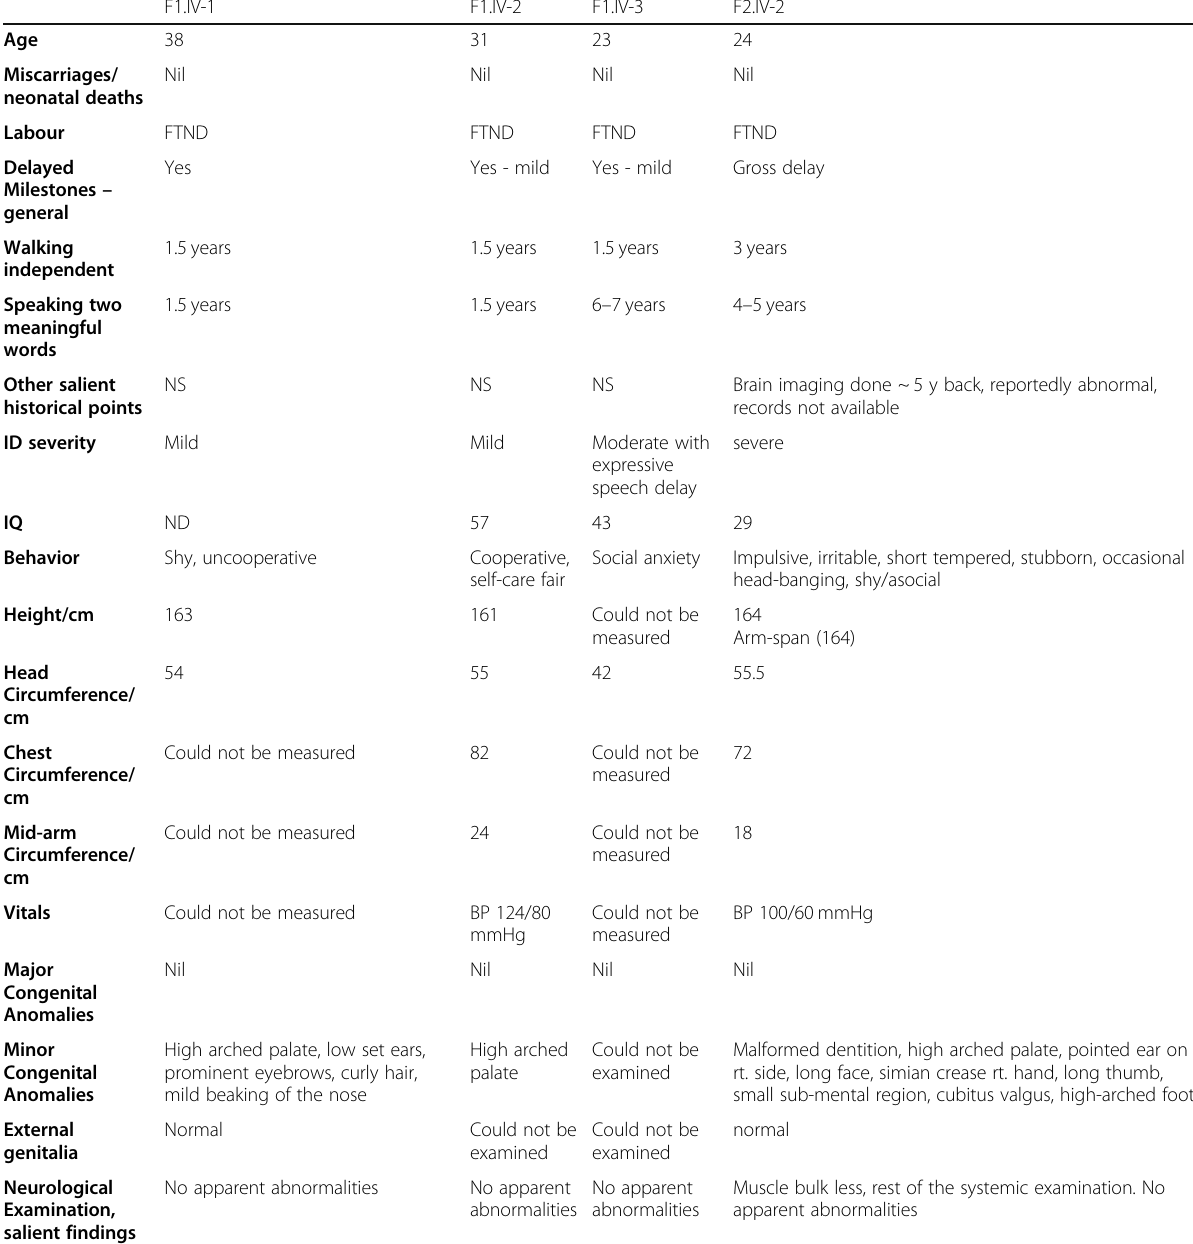
Table 1 Clinical phenotypic features of all four